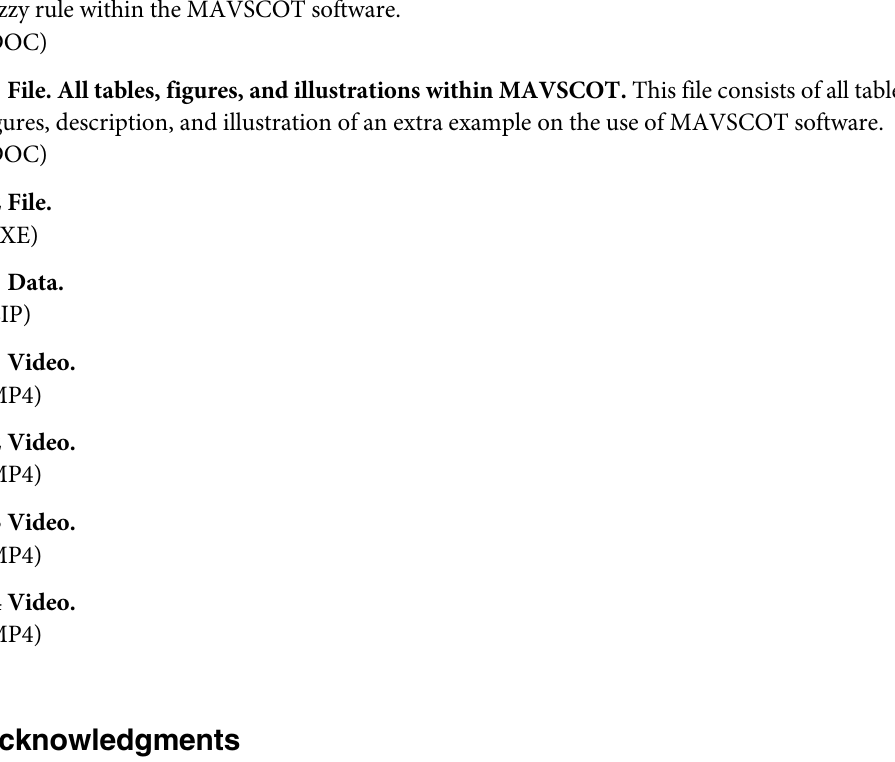
S14 Table. Triangular fuzzy function values. This table shows the Triangular Fuzzy Function Values. S15 Table. Table of 24 HIV symptoms, non-zero minimum values and HIV diagnosis. This table shows the 24 HIV symptoms, and how the Fuzzy Rule-base values have been able to pro- duce HIV diagnosis and their non-zero minimum